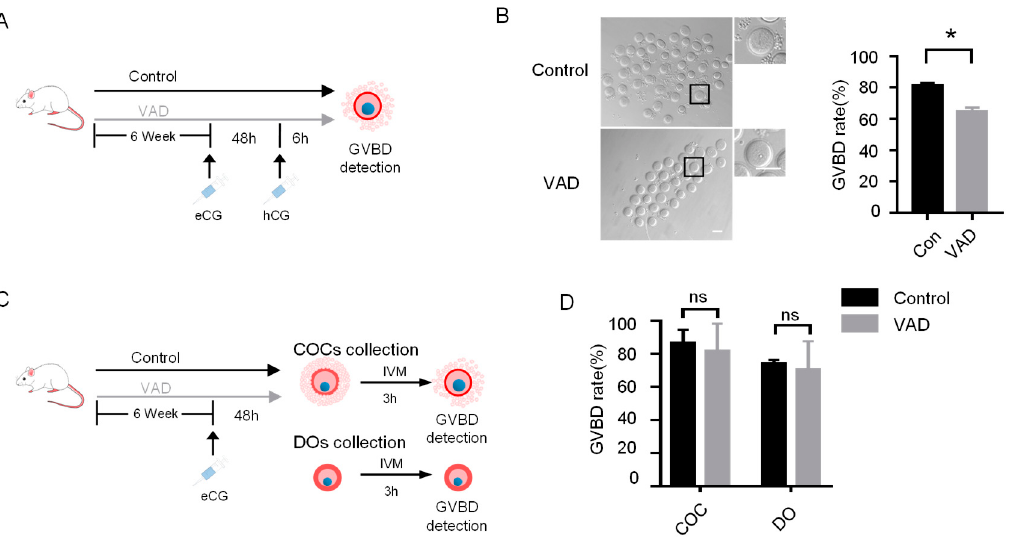
Figure 1. VA deficiency impairs oocyte meiotic resumption. ( A ) Flow chart of experimental design based on in vivo VAD mouse model. ( B ) Quantitative analysis of GVBD rates in control and VAD mouse. * p < 0.05. Left panel: representative image of GV and GVBD oocytes from control or VAD mouse. ( C , D ) Flow chart of experimental design in vitro maturation (IVM) of COCs and DOs from control and VAD mouse ( C ) and quantitative analysis of GVBD rates when using COCs or DOs. All data are presented as the mean ± SEMs of three independent experiments. ns, not significant ( p > 0.05). * p <